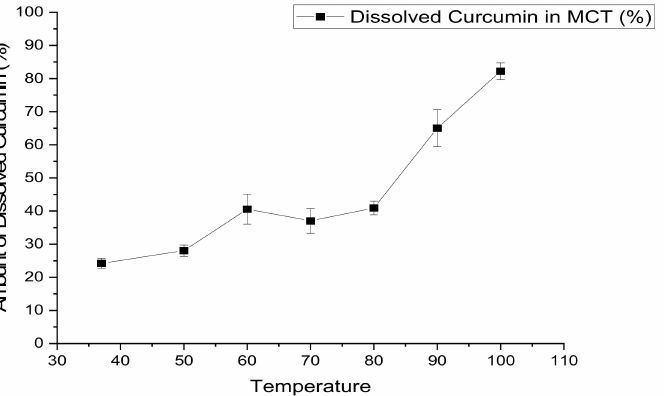
Figure 6. The amount of dissolved CUR (%) in heated MCT oil over a range of temperature from 37 to 100 ◦ C in a water bath. The application of heat is suggested to improve the CUR solubility and stability in encapsulation.